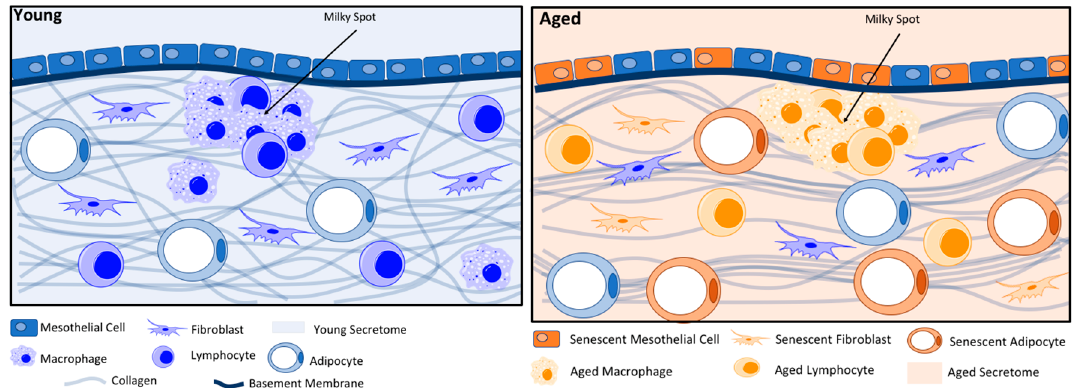
Figure 1. Changes in the Aged Microenvironment. Young: In the young metastatic microenvironment, collagens I and III form a directionally random meshwork that supports the tissue. In addition, there are low rates of senescence in mesothelial cells, fibroblasts and adipocytes, all of which secrete factors into the extracellular environment, forming the young secretome. The young secretome is characterized by decreased Matrix Metalloproteinase (MMP) expression, increased cytokine expression by immune cells, decreased cytokine expression by fibroblasts and decreased adipocyte-associated inflammatory factors. Milky spot immune cell aggregates exist in both young and aged metastatic environments, providing the tumor with abundant vascularization. Aged: In the aged metastatic microenvironment, there are lower levels of collagens I and III, which are remodeled to form more aligned, linear structures. In addition, higher levels of senescence alter the secretome, increasing inflammation and other factors that can promote ovarian cancer (OvCa) metastasis.